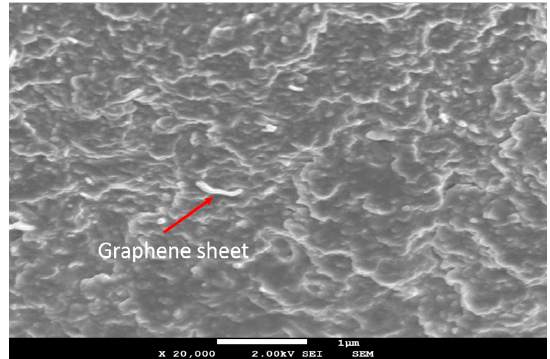
Figure 2. SEM (scanning electron microscopy) micrograph of a graphene sheet in epoxy matrix (scale bar = 1 μ m). (scale bar = 1 µ